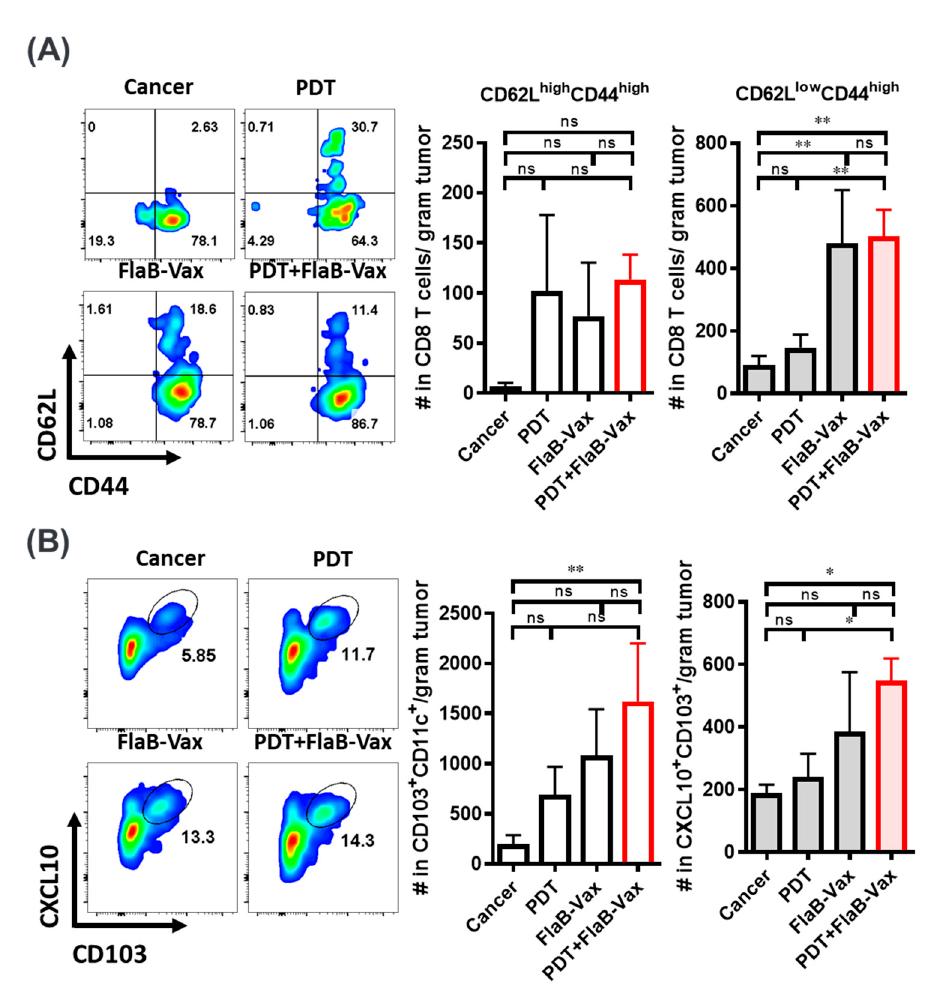
Figure 3. Increase in tumor-infiltrating memory CD8 + T cells and CD103 + dendritic cells (DCs) producing CXCL10 after treatments. Seven days after completion of all treatments of B16-F10-bearing mice, tumor-infiltrating lymphocytes (TILs) were prepared as a single-cell suspension with CD45 + MACS beads. ( A ) Representative flow plots and numbers of cells per gram of tumors of CD44 by CD62L expression on CD8 + T cells in TILs. ( B ) Representative flow plots and cell numbers per gram of tumors of CXCL10 + , CD103 + , and CD11C + DCs. The results are presented as the mean ± SEM ( n = 5 per group). *, p < 0.05; and **, p < 0.01.